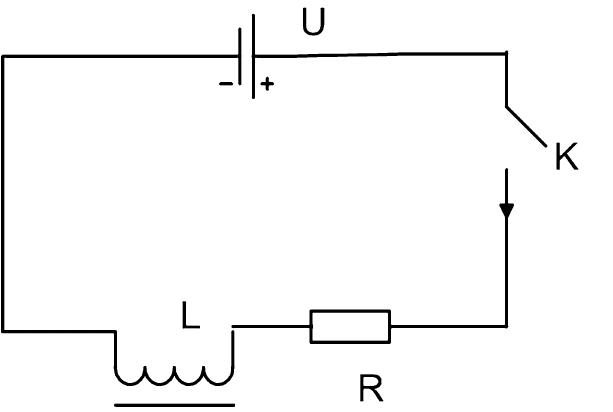
Figure 4. The DC power supply of the circuit breaker.